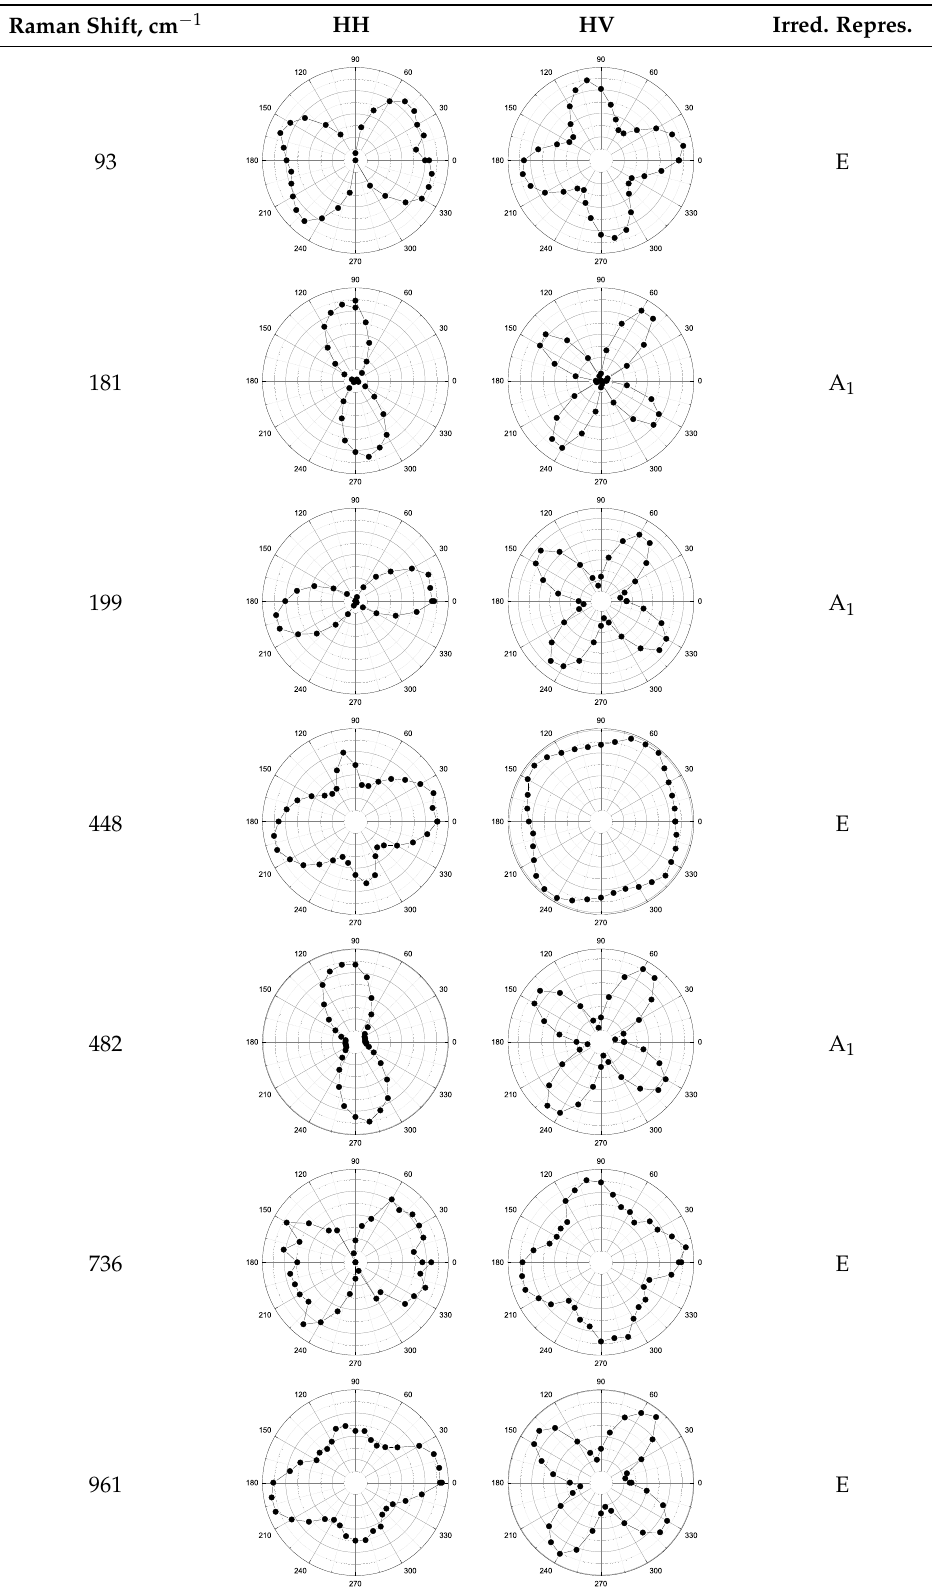
Table 2. Dependence of the peak position of the vibrational mode on the angle of rotation. Back scattering geometry at 296 K ( R 32 phase) in TbFe 2.46 Ga 0.54 (BO 3 ) 4 crystal. Raman Shift, cm − 1 HH HV Irred. Repres.